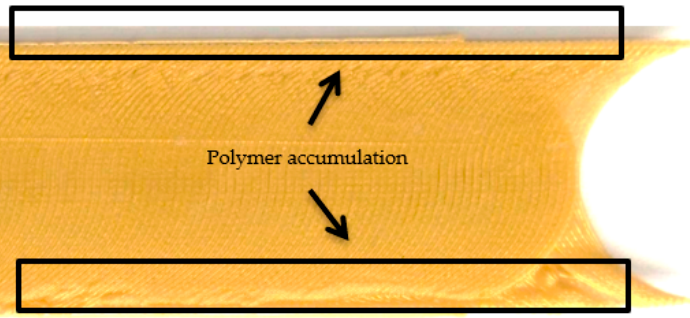
Figure 8. Polymer accumulation and reduced surface finish when the filament feed increased as a constant value.